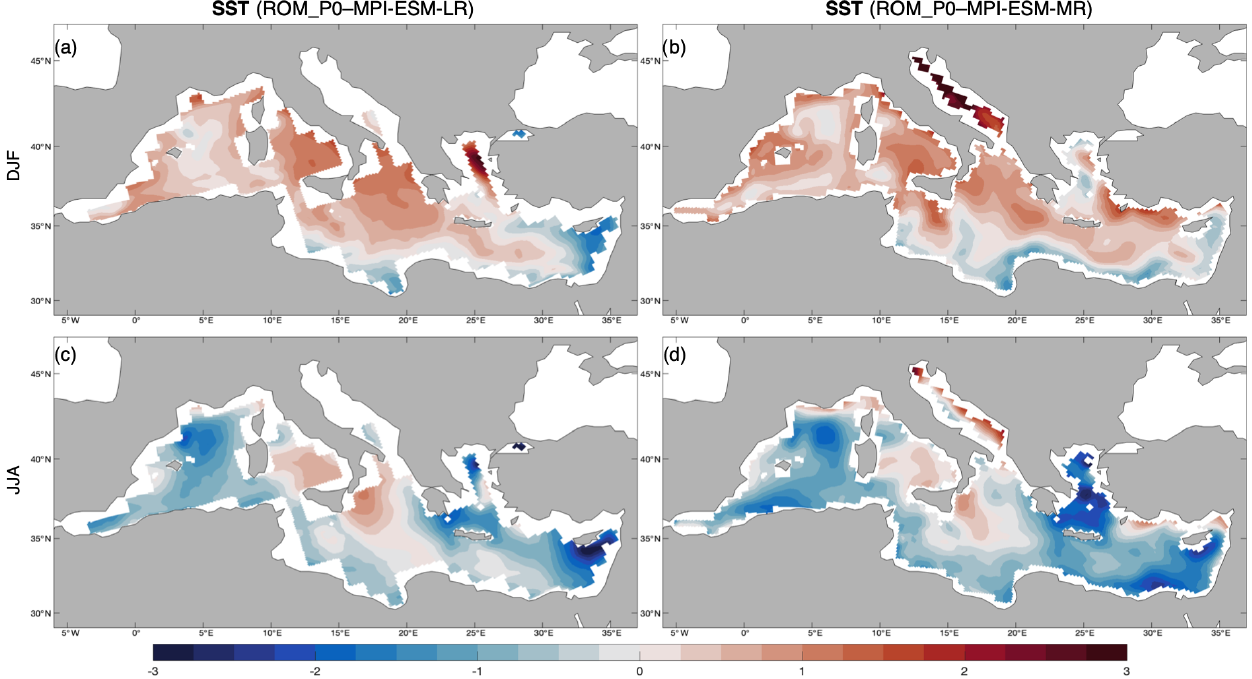
Figure 6. SST differences ( ◦ C) between ROM_P0 and MPI-ESM-LR (a, c) and MPI-ESM-MR (b, d) in winter (DJF a, b ) and summer (JJA c, d